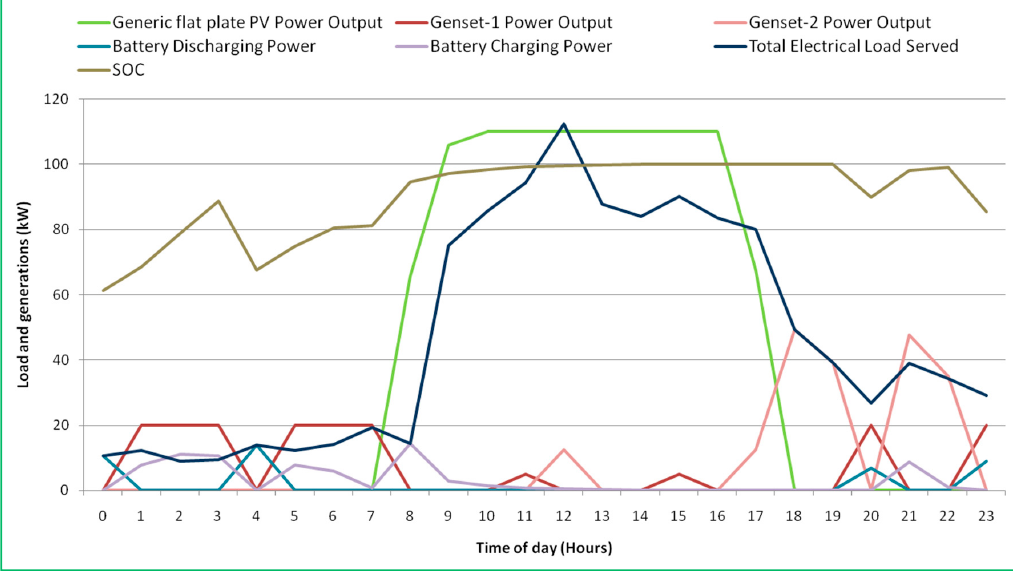
Figure 9. Load and generation on a random day of the dry season for the best combination of Case-2.